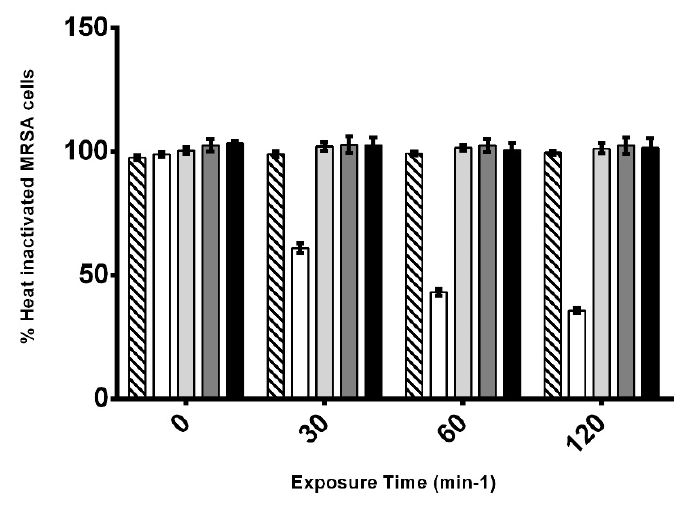
Figure 4. Lysis assay of heat-inactivated cells of MRSA CIP 106760 strain, with different concentrations of 7α-acetoxy-6β-hydroxyroyleanone. The optical density (OD 600nm ) of the cell suspensions was measured at discrete time points for the effect of DMSO (black bar), 100 mg/L of lysostaphin (white bar) and different concentrations of ARH; MIC/2 (3.9 mg/L; medium grey bar); MIC (7.8 mg/L; light grey bar) and 2 MIC (15.6 mg/L; dark grey bar). Experiments were performed in triplicate. Shown are means with the standard error.